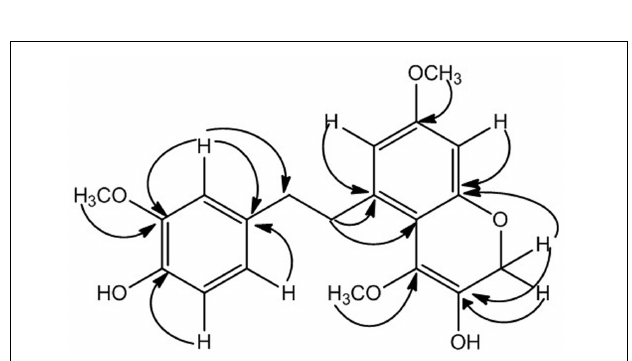
FIGURE 1 | Structures of compounds 1 and 2 (Zhan et al., 2016).